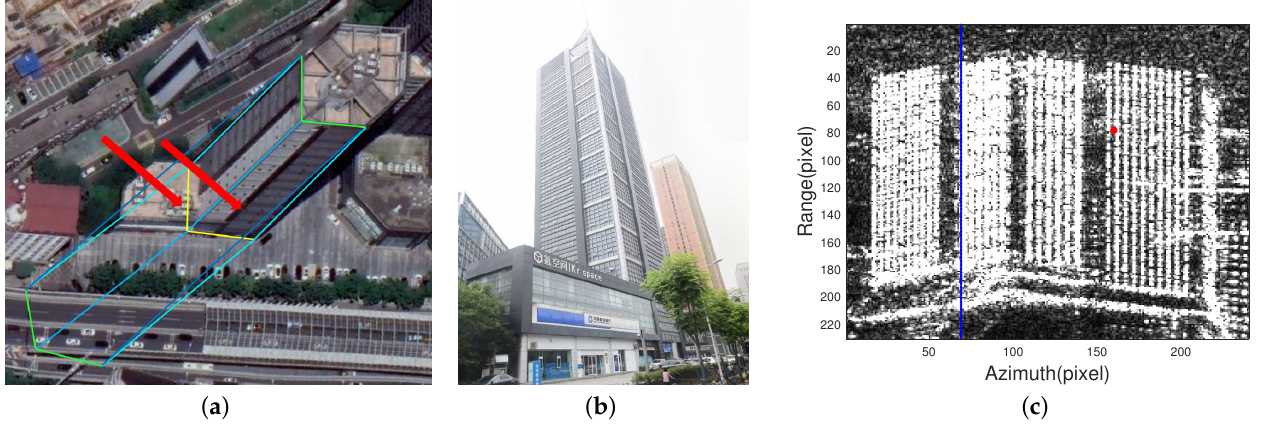
Figure 11. The optical and SAR image of Hubei Science and Technology Venture Building. ( a ) The imaging geometry of the building. ( b ) Street-view image from Baidu Map. ( c ) SAR image of Hubei Science and Technology Venture Building. The red point was selected to demonstrate the necessity of baseline compensation in Section 4.2.1. And the blue line was chosen to display the tomographic profiles in Section